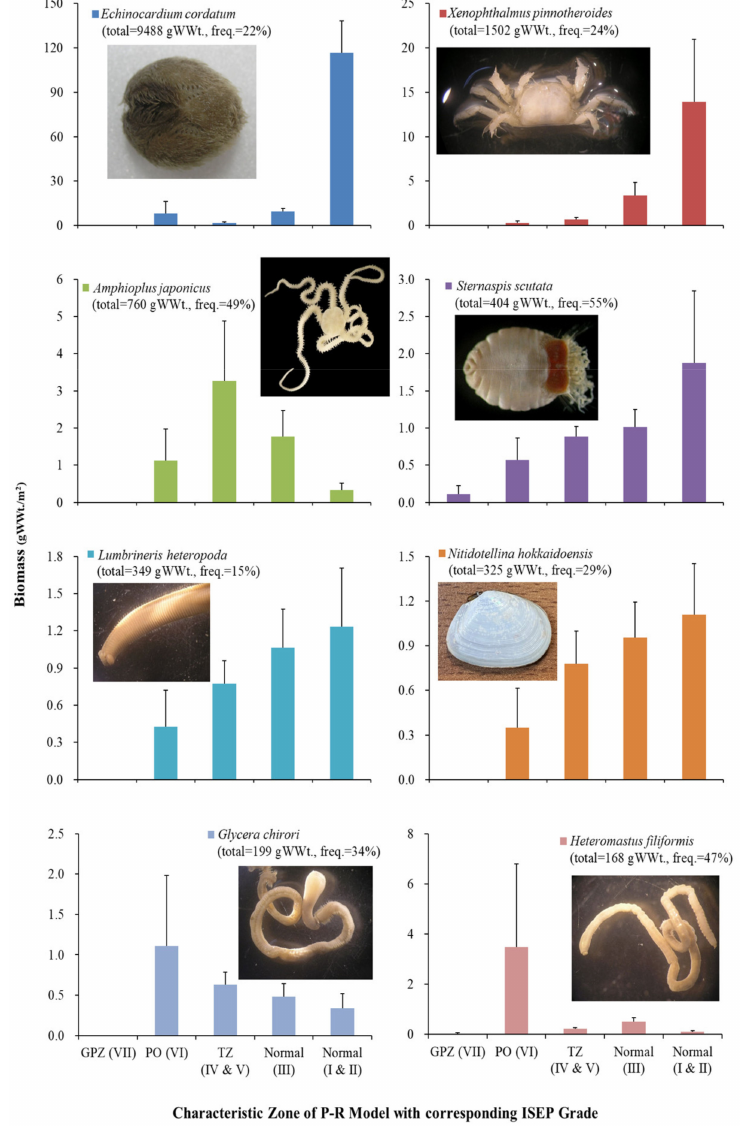
Figure 8. Variations in the biomass of dominant species along the characteristic zones. The data are shown for each dominant species of high biomass. ISEP grades are shown on the x -axis from low quality (grade VII) to high quality (grade I) to allow the direct comparison with the P-R model. Note that TZ = transitory zone, PO = peak of opportunists, and GPZ = grossly polluted